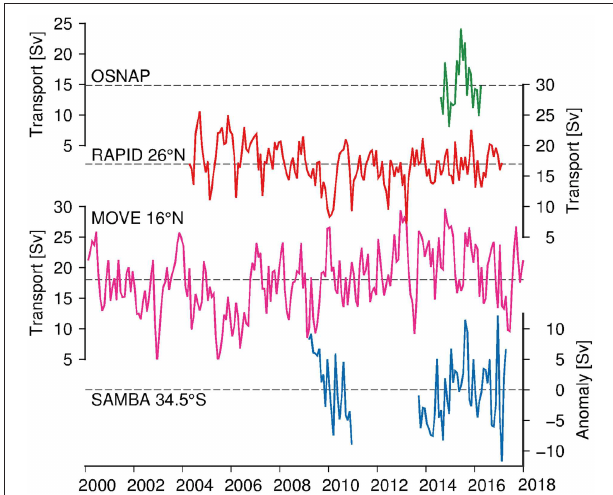
FIGURE 4 | Monthly values of MOC z transport from four observing arrays: OSNAP (green), RAPID 26 ◦ N (red), MOVE 16 ◦ N (magenta) and SAMBA 34.5 ◦ S (blue). For SAMBA, the transports are shown as anomalies (see section 2.4). The respective means are given by the black dashed line (zero in the case of